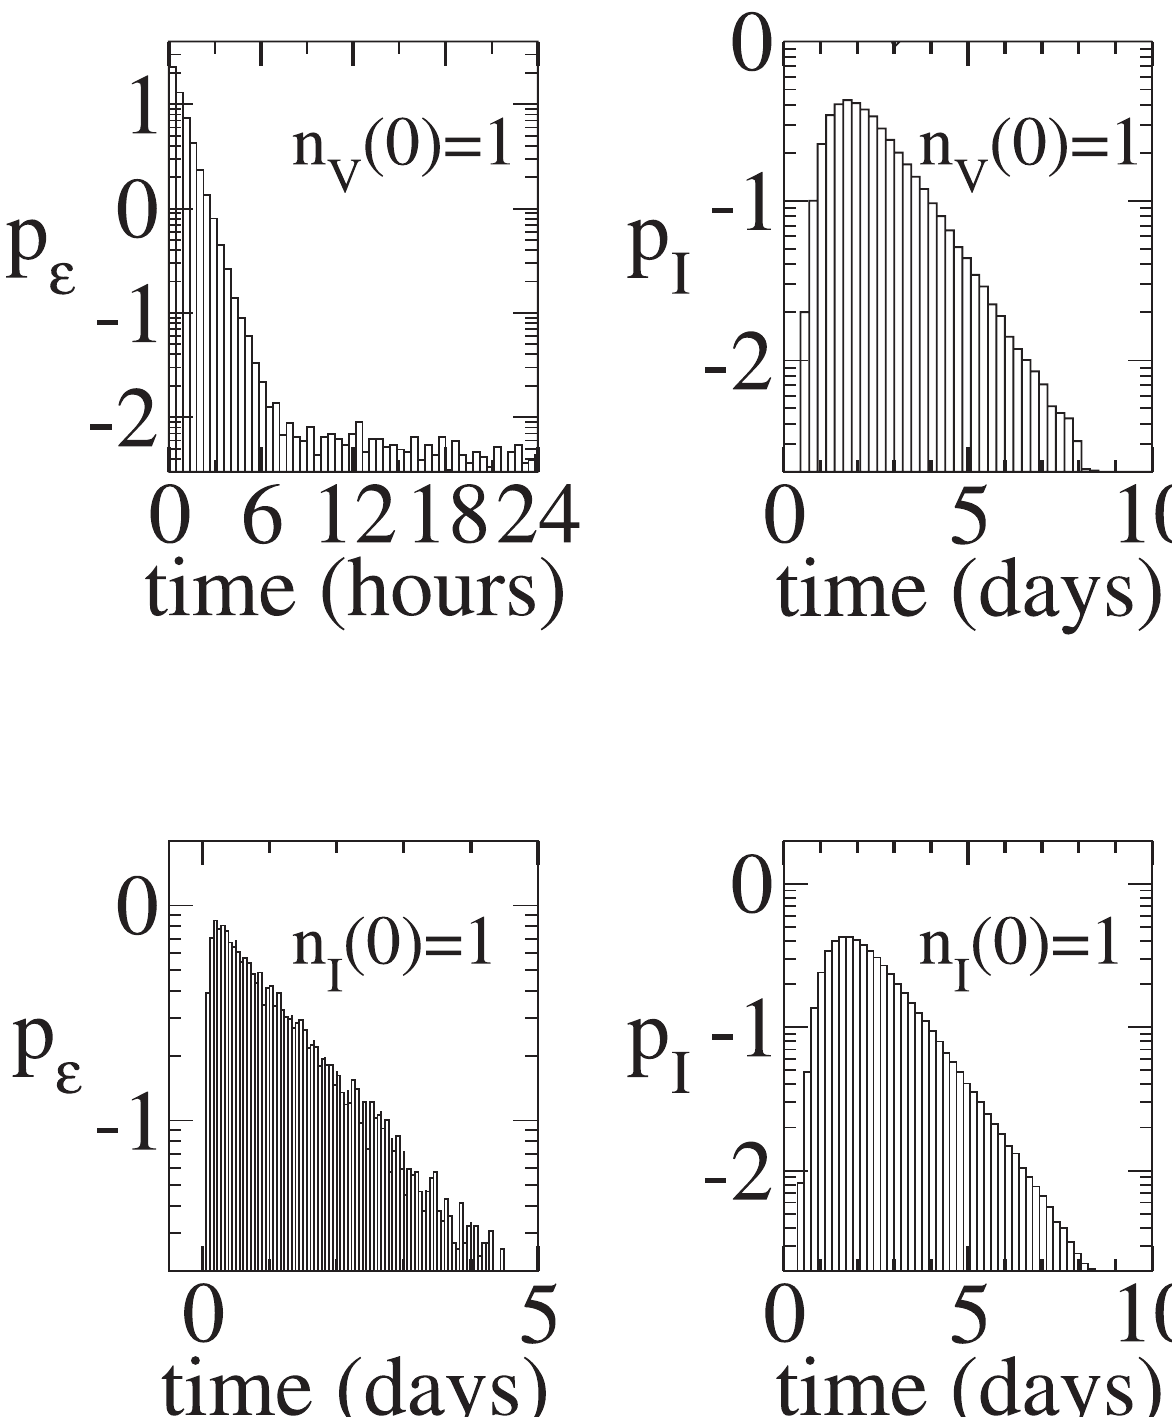
PLoS Computational Biology |